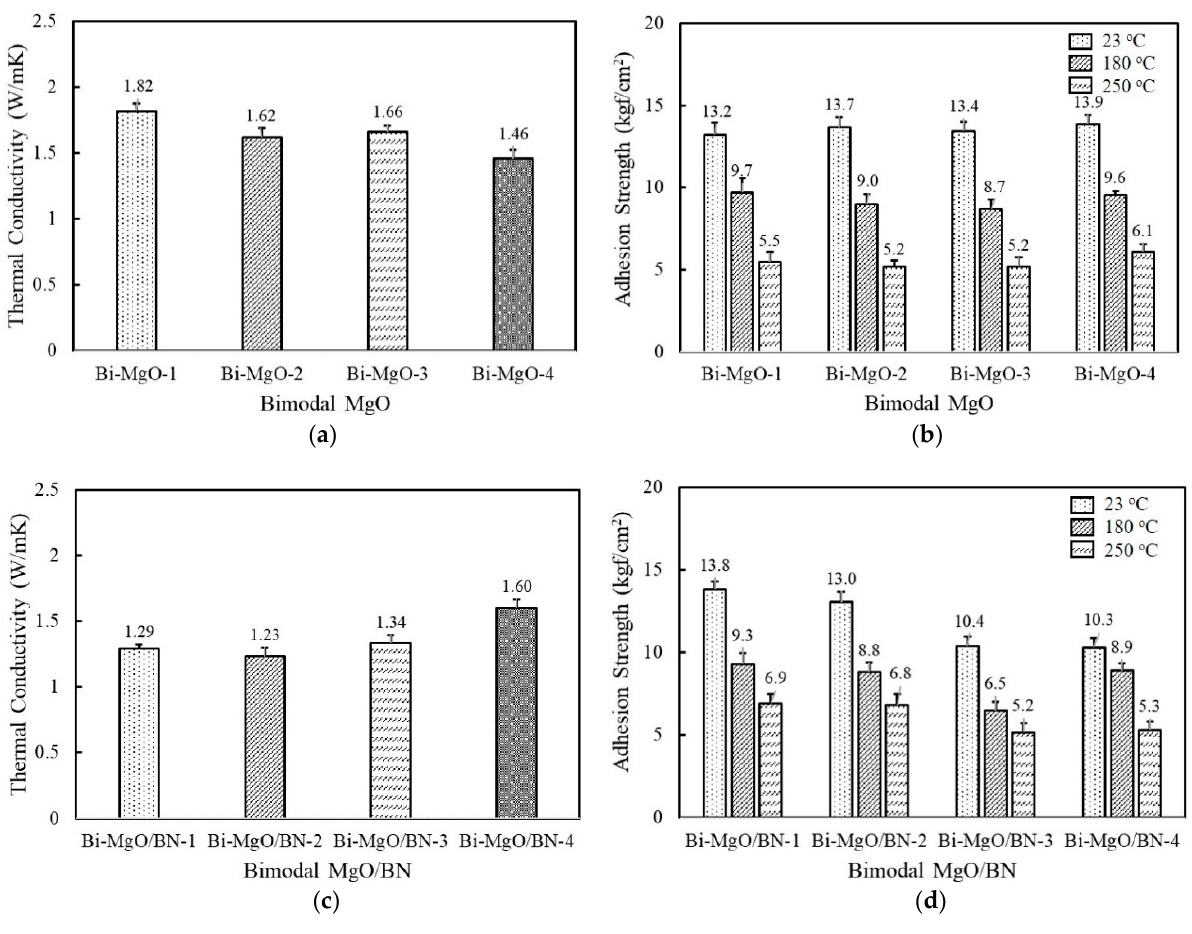
Figure 4. Thermal conductivity and adhesion strength of fluorosilicone adhesives containing two ‐ component MgO and BN fillers: ( a ) thermal conductivity of bimodal MgO adhesives; ( b ) adhesion strength of bimodal MgO adhesives measured at 23 °C, 180 °C, and 250 °C; ( c ) thermal conductivity of bimodal MgO/BN adhesives; ( d ) adhesion strength of bimodal MgO/BN adhesives measured at 23 °C, 180 °C, and 250 °C. The filler concentration was kept at 60